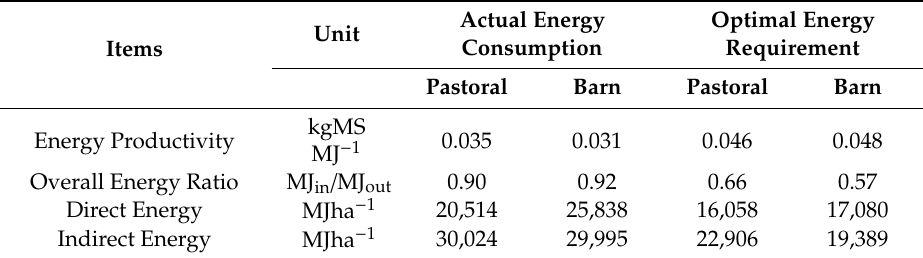
Figure 3. Percentage distribution of energy savings potential for PDFs and BDFs. Table 6. Energy indices improvement for pastoral and barn dairy systems (50